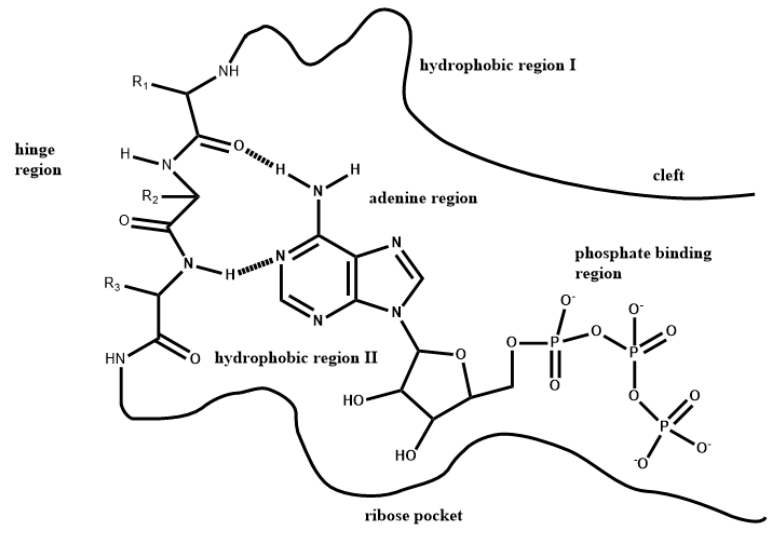
Figure 6. Pharmacophore model for Type 1 PKIs in the ATP binding pocket of protein kinases. In contrast, the Type 2 PKIs bind to the DFG-out inactive (closed) conformation of protein kinases. They occupy the adenosine pocket and still have contact with the hinge.